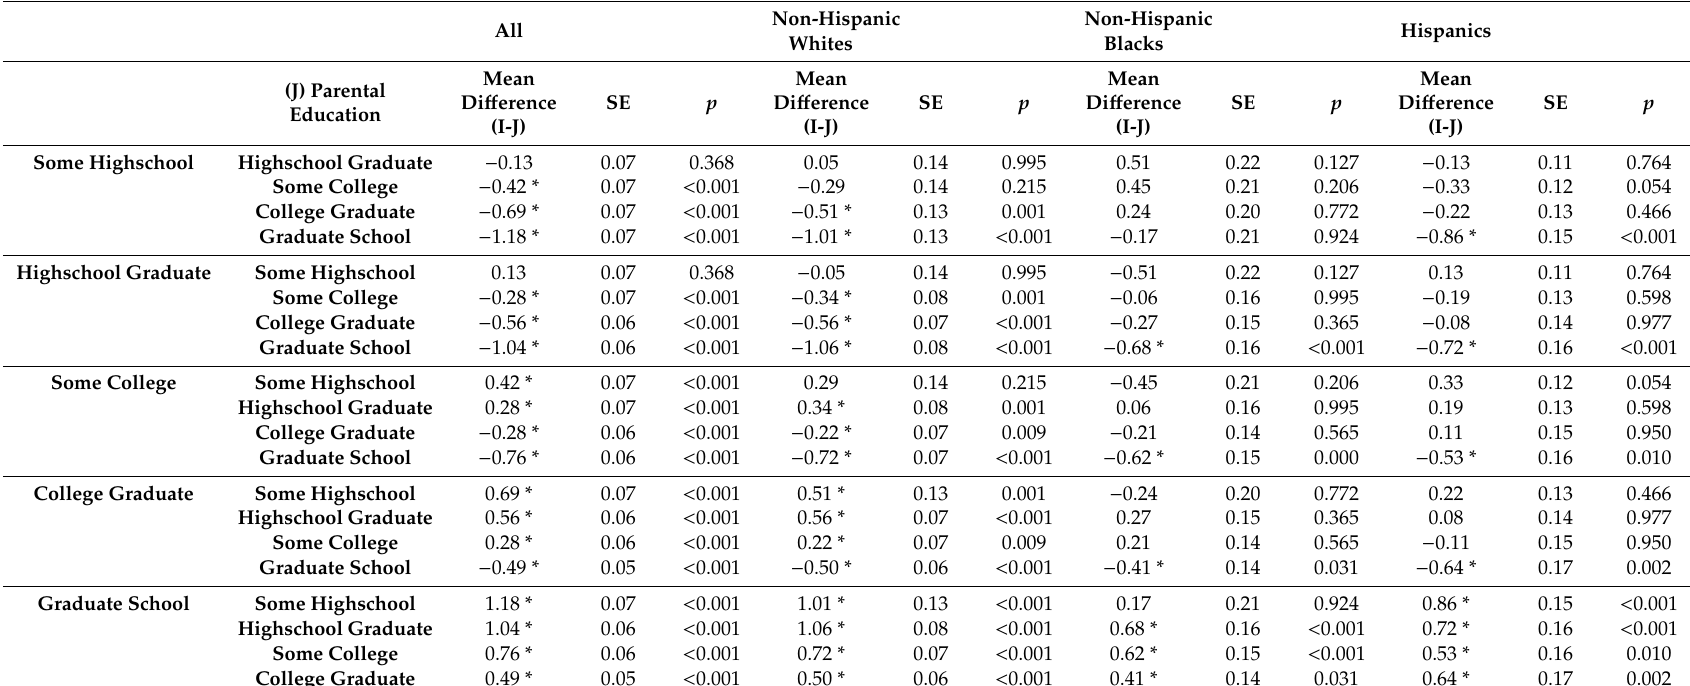
Table 4. Post Hoc test overall and by